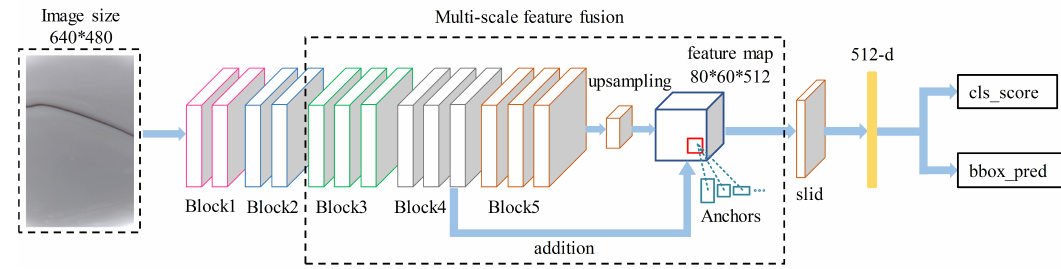
Figure 5. The multi-scale feature fusion framework.